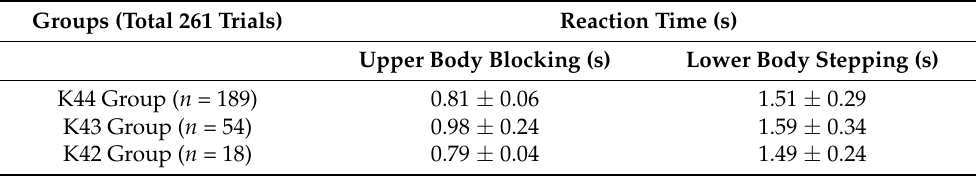
Table 1. Difference between the reaction times for the K42, K43, and K44 athletes. Groups (Total 261 Trials)